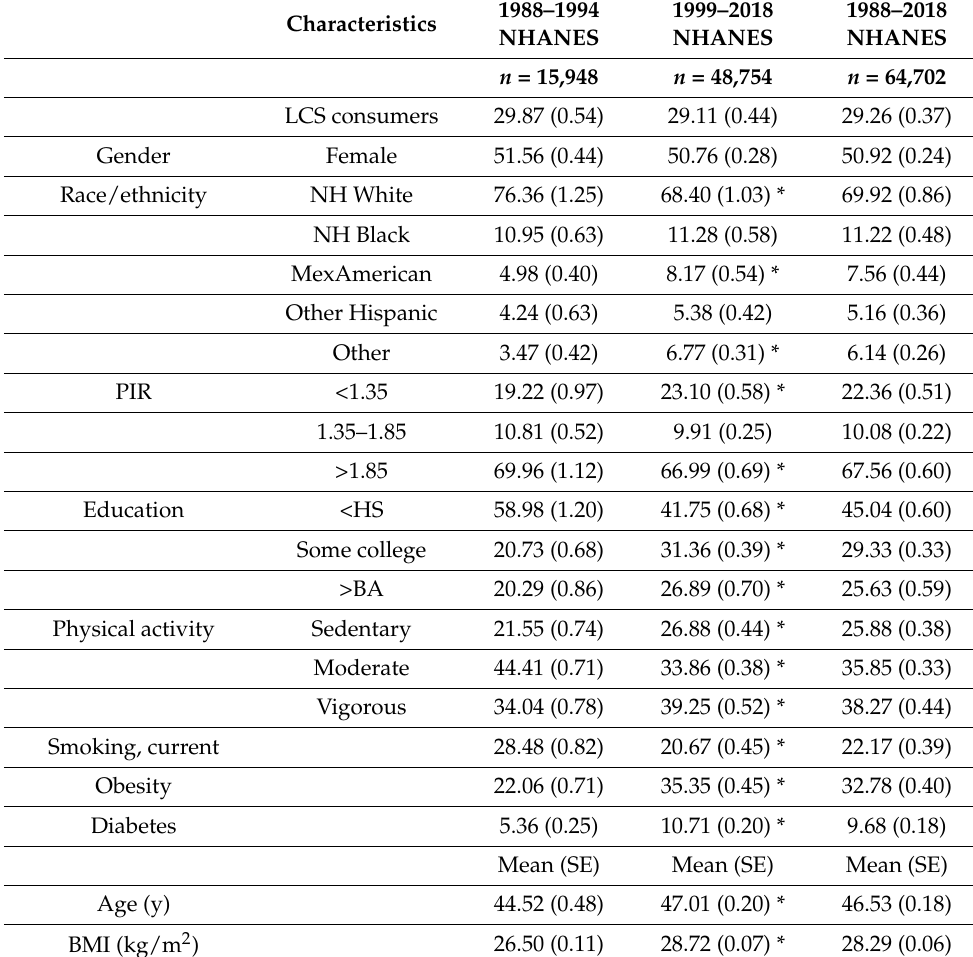
Table 2. Participant characteristics for adults >19 years in NHANES 1988–2018. Data are percentages (standard error—SE) and means (SE). Data adjusted for complex sample design of NHANES and used relevant sample